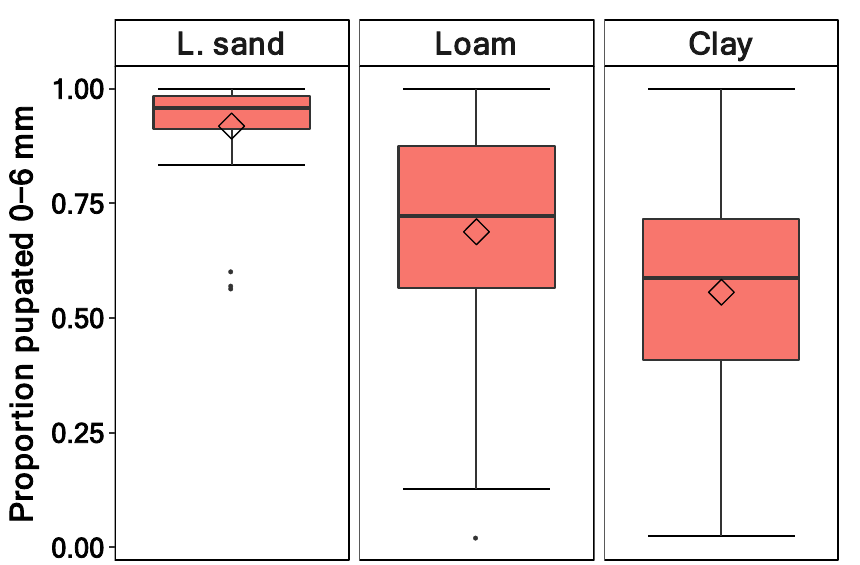
Figure 1. Proportion of Drosophila suzukii pupae that pupated in the upper layer (0–6 mm) in relation to the lower layer (7–12 mm). The larvae pupated in the three different soil types: loamy sand, loam and clay (n = 96).